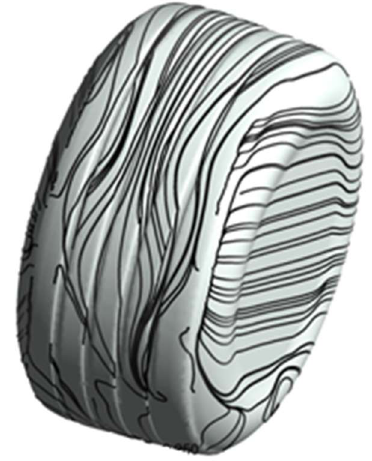
Figure 4. Wheel wall shear stress surface streamlines.